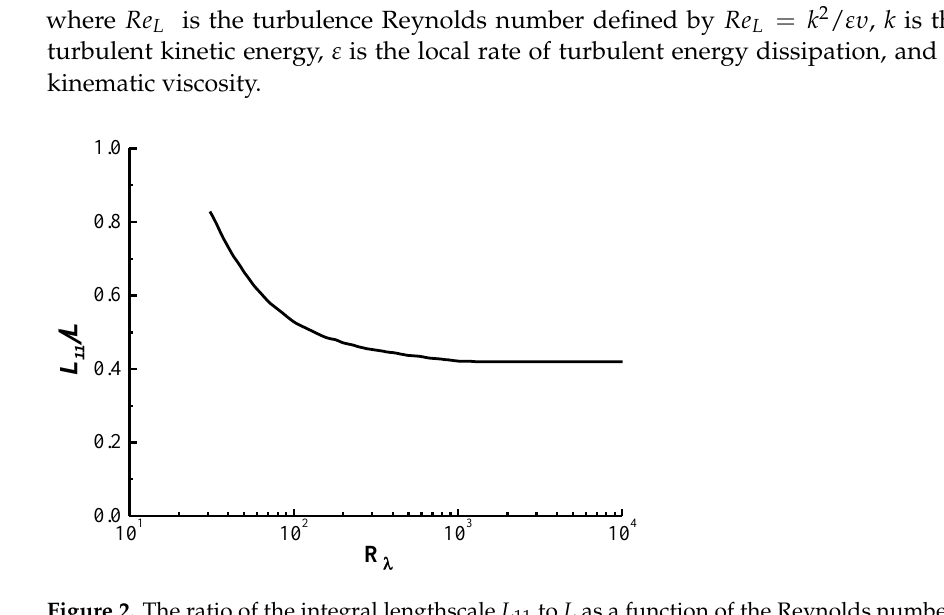
Figure 2. The ratio of the integral lengthscale L 11 to L as a function of the Reynolds number for the model spectrum.